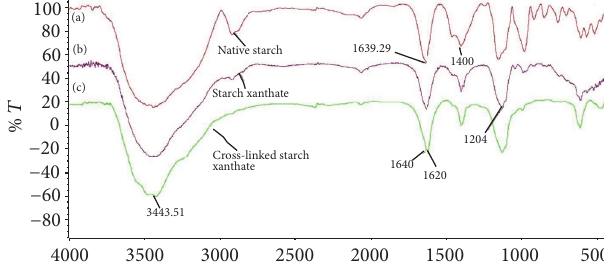
Figure 6: IR spectrum of starch, starch xanthate, and cross-linked starch xanthate. Table 1: Quantitative data of EDX measurement for cross-linked starch xanthate adsorbed Pb 2+ . ElAN series unn.